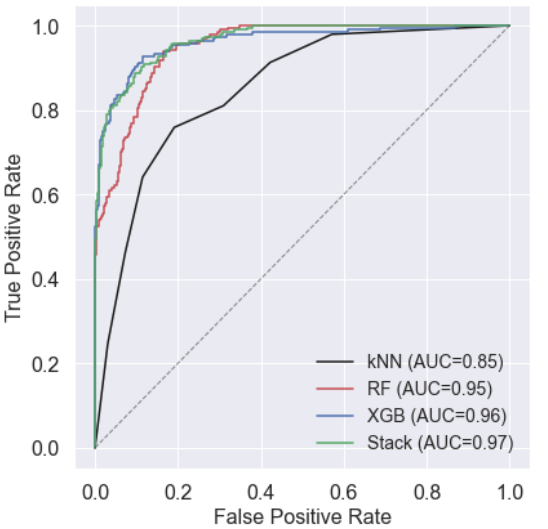
Figure 8. ROC curves for the proposed four different classification algorithms. The diagonal dashed line represents the random classification